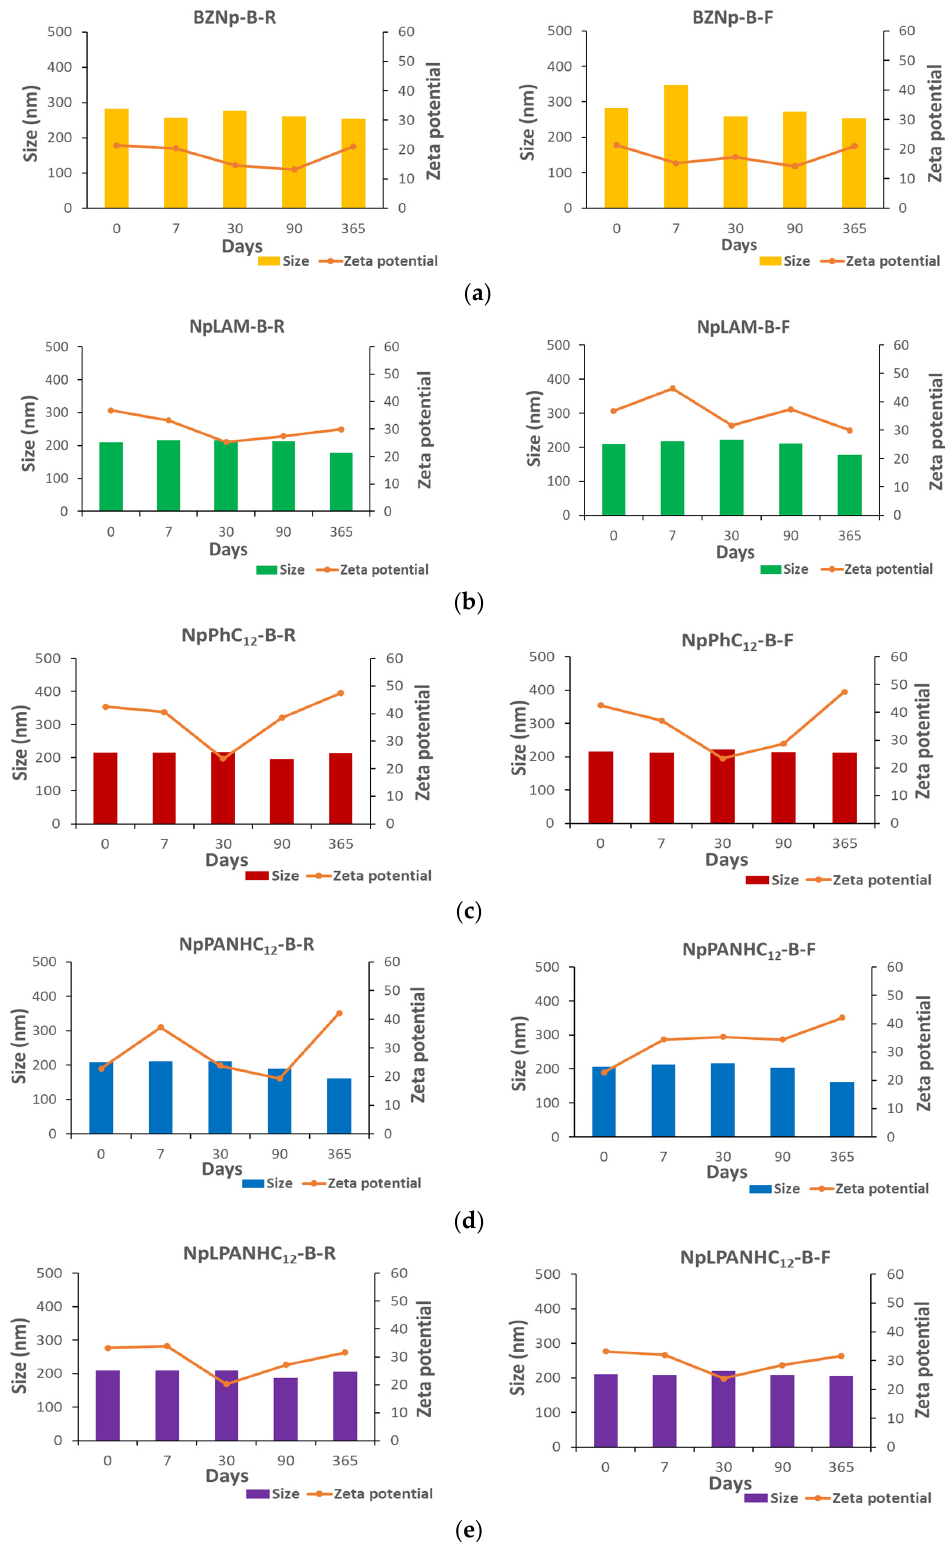
Figure 4. Size (nm) and zeta potential (mV) of: ( a ) blank, ( b ) LAM, ( c ) PNHC 12 , ( d ) PANHC 12 and ( e ) C 12 PAM loaded-zein nanoparticles prepared by Method B and stored at room temperature (R) and freezer (F) over 365 days.